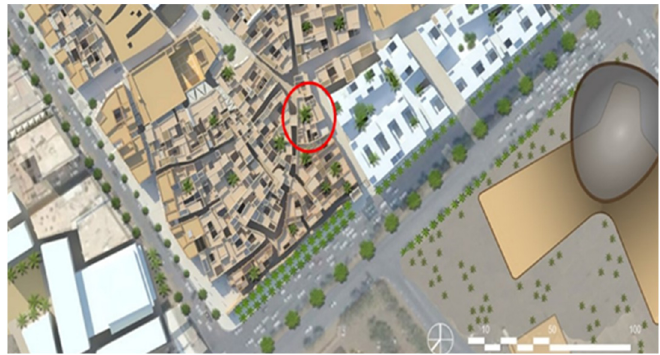
Figure 9. The location of the traditional house for the vernacular urban content in Riyadh city.